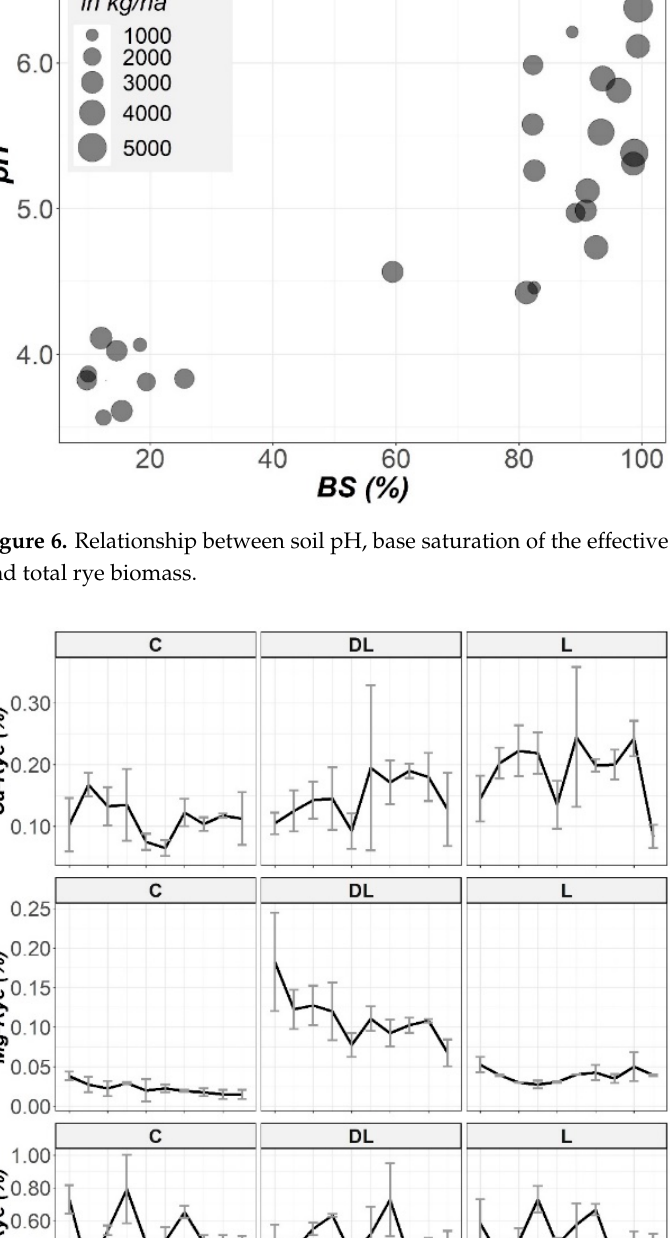
Figure 5. Temporal evolution of the spike, stem and total biomass throughout the ten years of bio- mass monitoring (2002–2011).